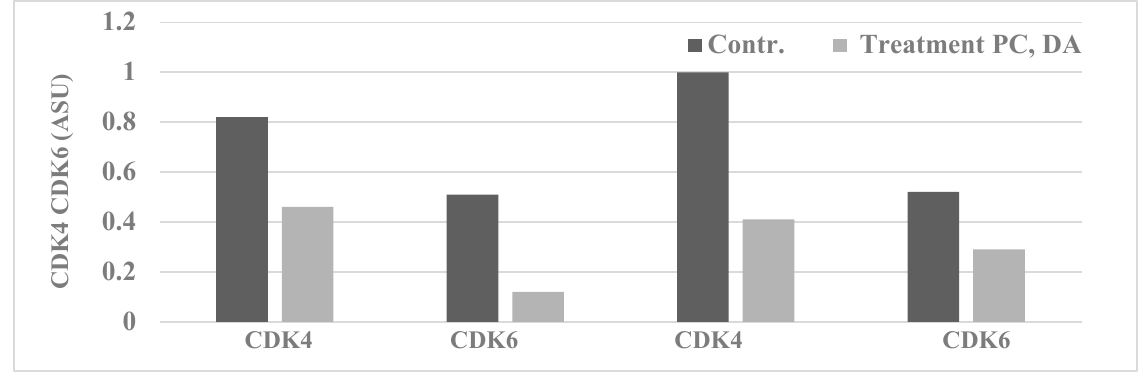
Figure 3. Effect of Chinese herbs on CDK4 and CDK 6 expression. Treatment with PC and DA at their respective IC 90 doses inhibited the expressions of CDK4 and CDK6. Data presented as arithmetic means of ASU from duplicate determinations. CDK, cyclin dependent kinase; ASU, arbitrary scanning unit; Contr., Control; Treatment: PC, Psoralea corylifolia ; DA, Dipsacus asperoides . Data summarized from [15,16].